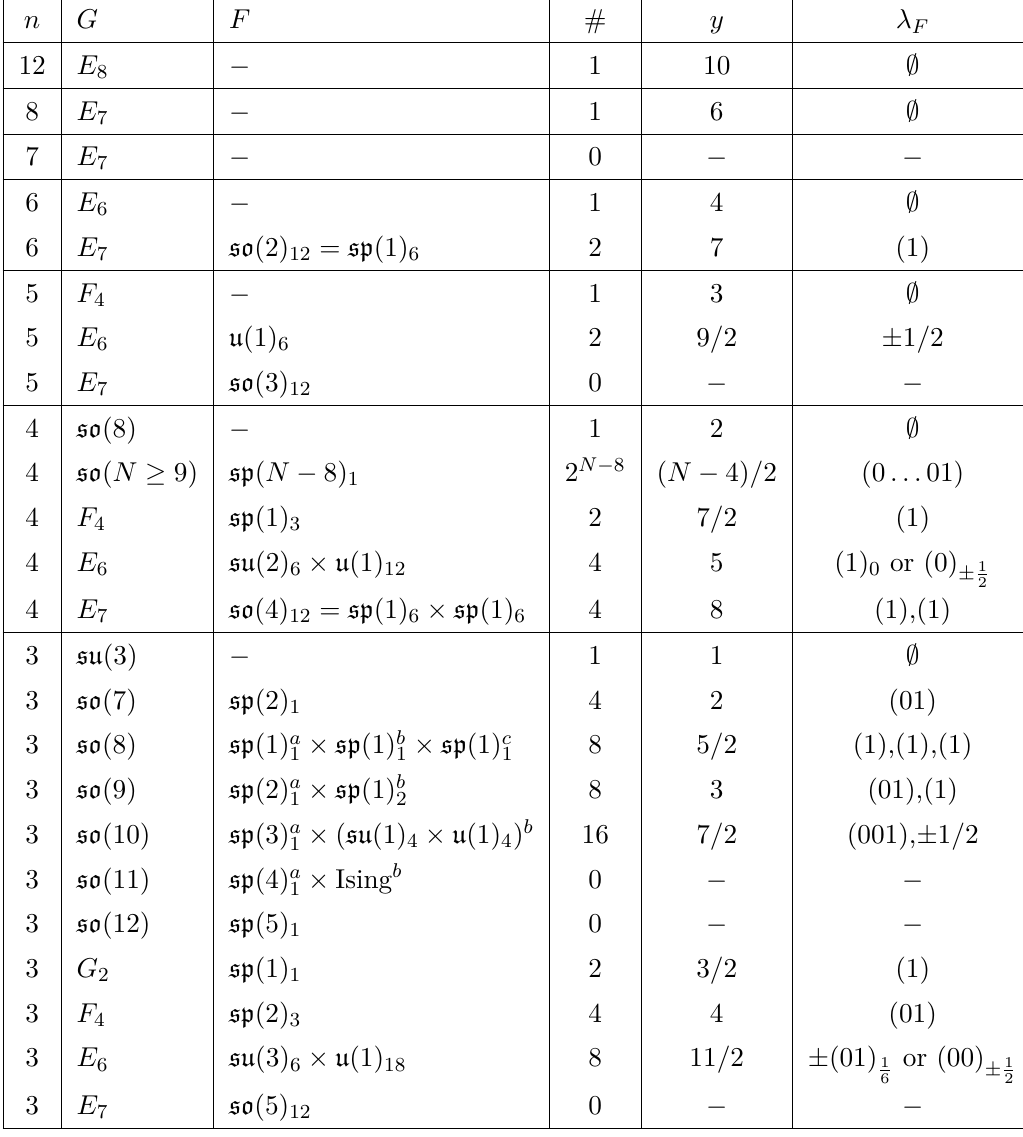
Table 5 . The parameters y, λ F of unity blowup equations for rank one models with n ≥ 3 . # is the number of unity equations with fixed characteristic a